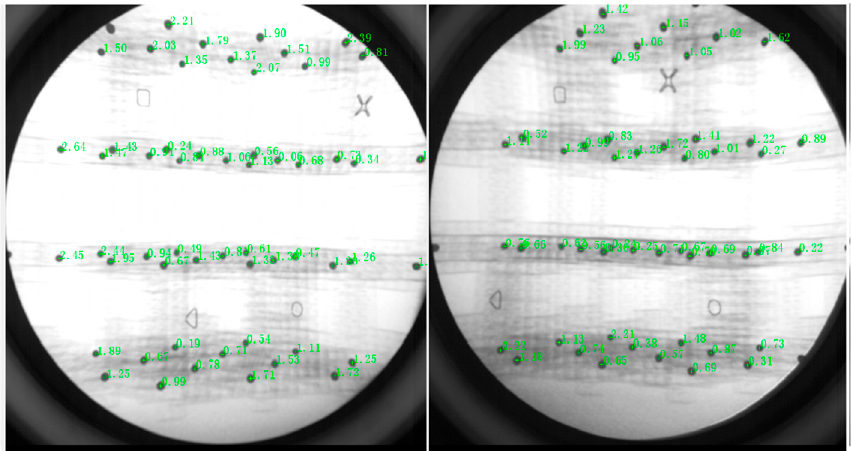
Figure 2. Systematic error correction.